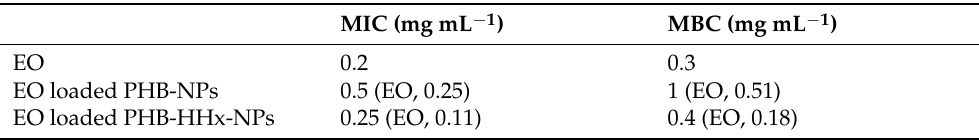
Table 4. MIC and MBC of free and encapsulated EO against M. luteus. Samples correspond to NPs obtained in trial S13 and H8 for PHB and PHB-HHx, respectively. Values in brackets refer to the concentration of encapsulated EO, based on the experimentally determined Loading capacity (51% and 45% for PHB and PHB-HHx,